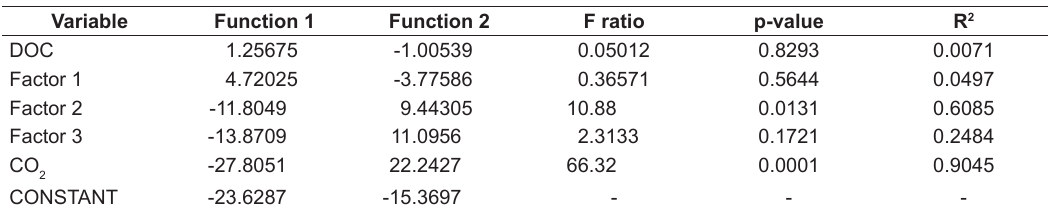
F ratio= F-test for ANOVA, 2.